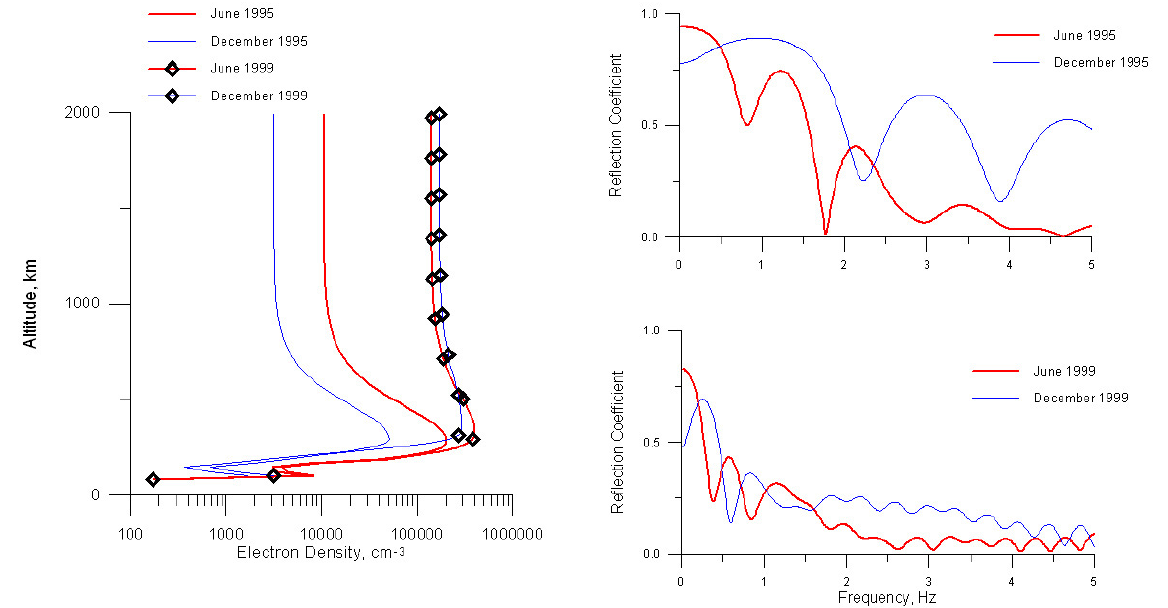
Fig. 4. (a) Altitude profiles of the ionospheric electron density above Sodankyl¨a according to the IRI-95 model for summer and winter conditions during solar minimum (1995) and maximum (1999). (b) Reflection coefficient of ionosphere as a function of frequency for summer and winter conditions during solar minimum (1995) and maximum (1999). The calculation has been done using the “full wave” algorithm by Ostapenko and Polyakov (1990) taking into account the ionosphere density profiles shown in Fig. 4a.